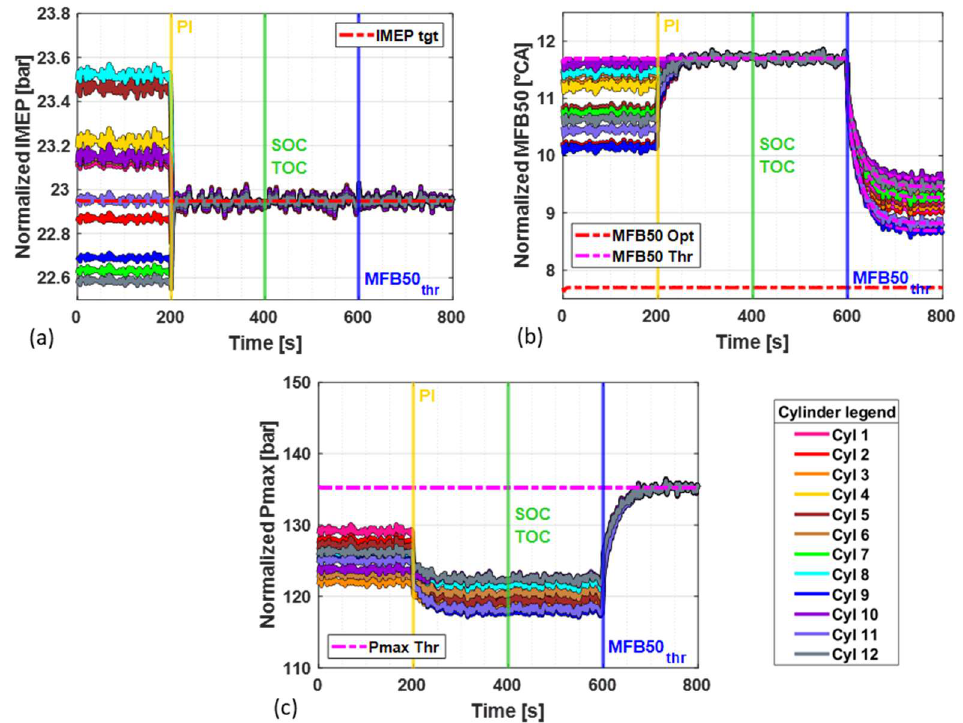
Figure 16. Behavior of the indicating variables feedback when the combustion controller strategies are activated in succession at 1800 rpm and 100% pedal: ( a ) IMEP, ( b ) MFB50, ( c ) Pmax.